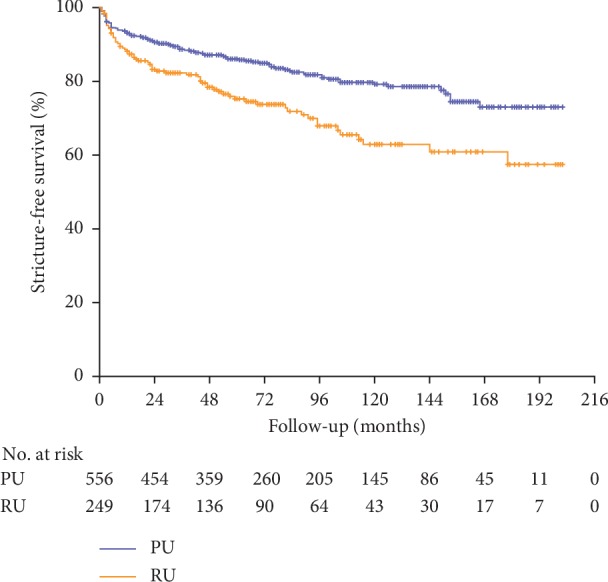
Kaplan–Meier curve for stricture-free survival in primary and redo urethroplasty. PU = primary urethroplasty; RU = redo urethroplasty; no. = numbers.